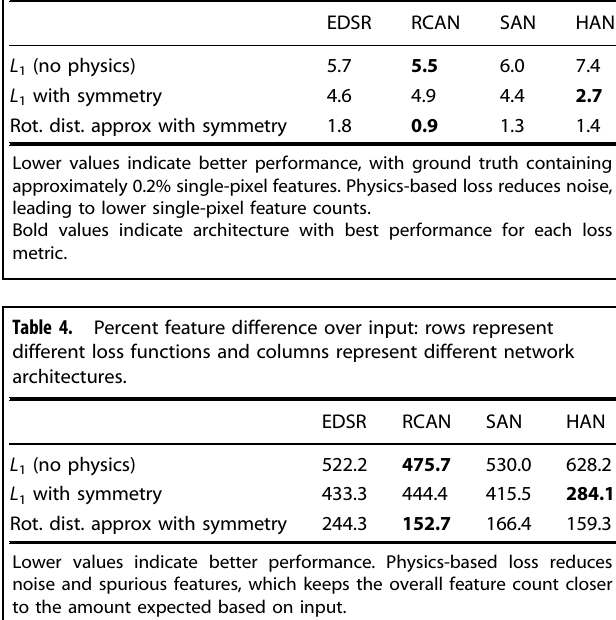
Table 3. Percentage of single-pixel features: rows represent different loss functions and columns represent different network architectures.